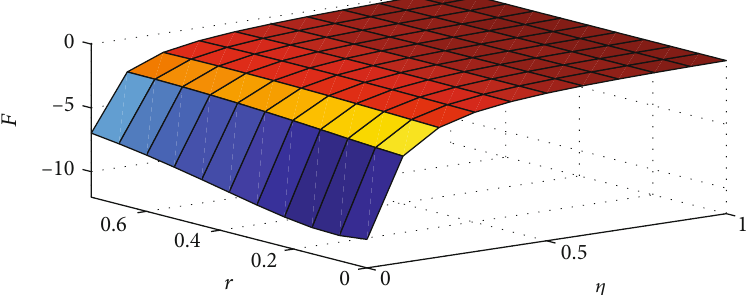
Figure 13: Plots of Equation (40) versus η and r , for A = 100 and κ = 0 : 8